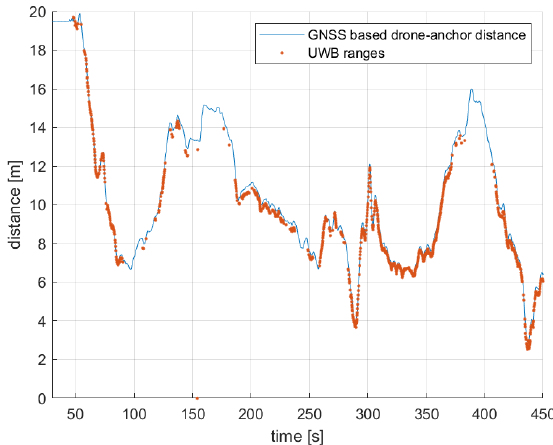
Figure 5. Example of range measurements between the drone and an anchor positioned on the ground (red dot marks), compared with GNSS-based ground truth distance (blue solid line).